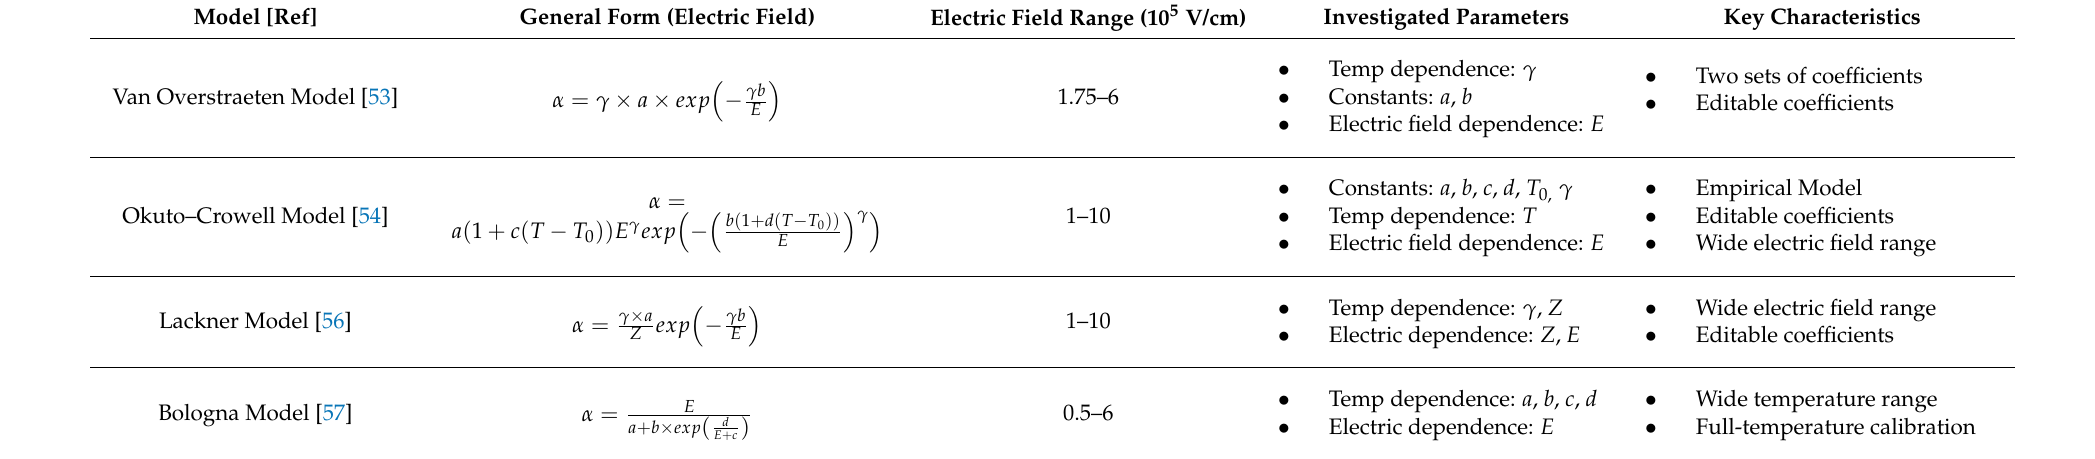
Table 1. Commonly Used Ionization Coefficient Models in Sentaurus